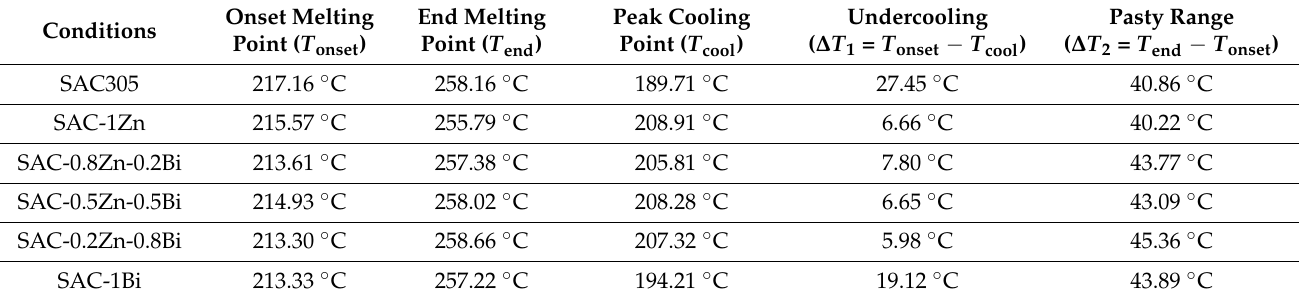
Figure 4. DTA results of experimental alloys. Table 3. Melting Temperature, undercooling and pasty range of experimental